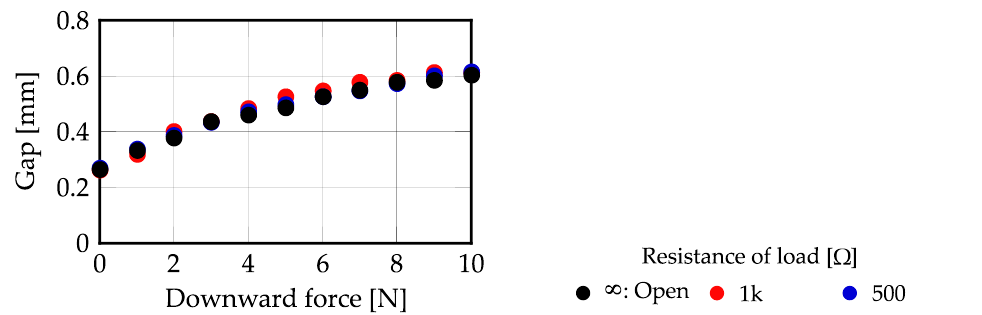
Figure 23. Static characteristics of the gap when downward force is applied.